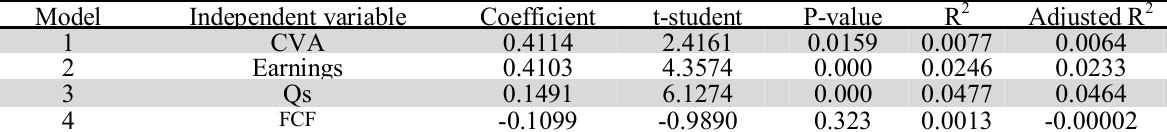
The summary of testing the first hypothesis